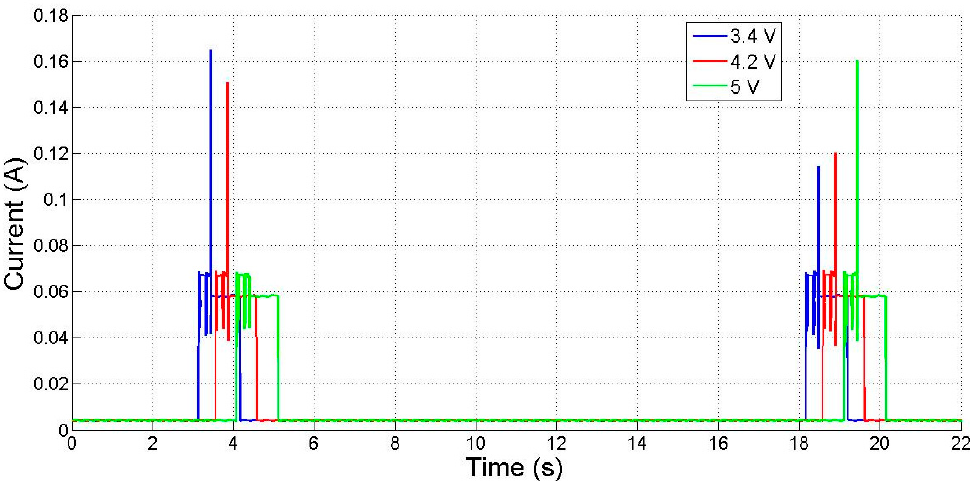
Figure 7. Mobile node current consumption. Nodes are biased by a nominal 3.7 V battery, charged to 5 V ( green ), 4.2 V ( red ) and 3.4 V ( blue ).